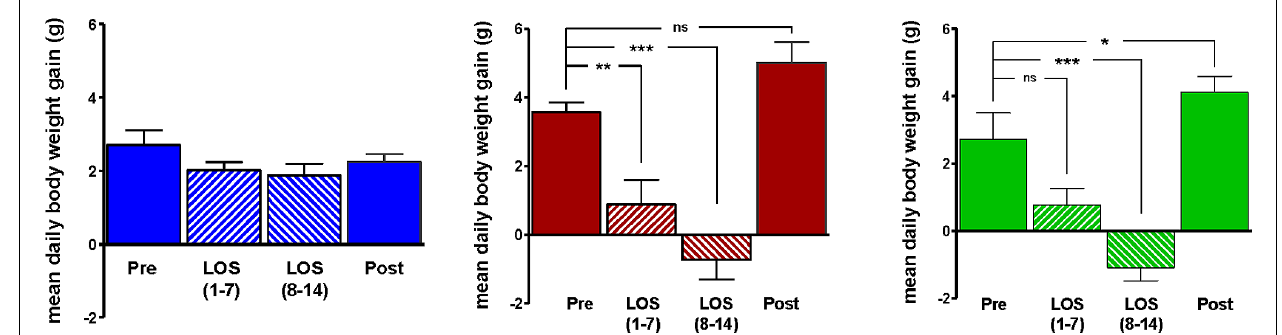
final 7 days (days 18–24) following losartan treatment (Post). Losartan attenuated body weight gain in DIO and DR animals as